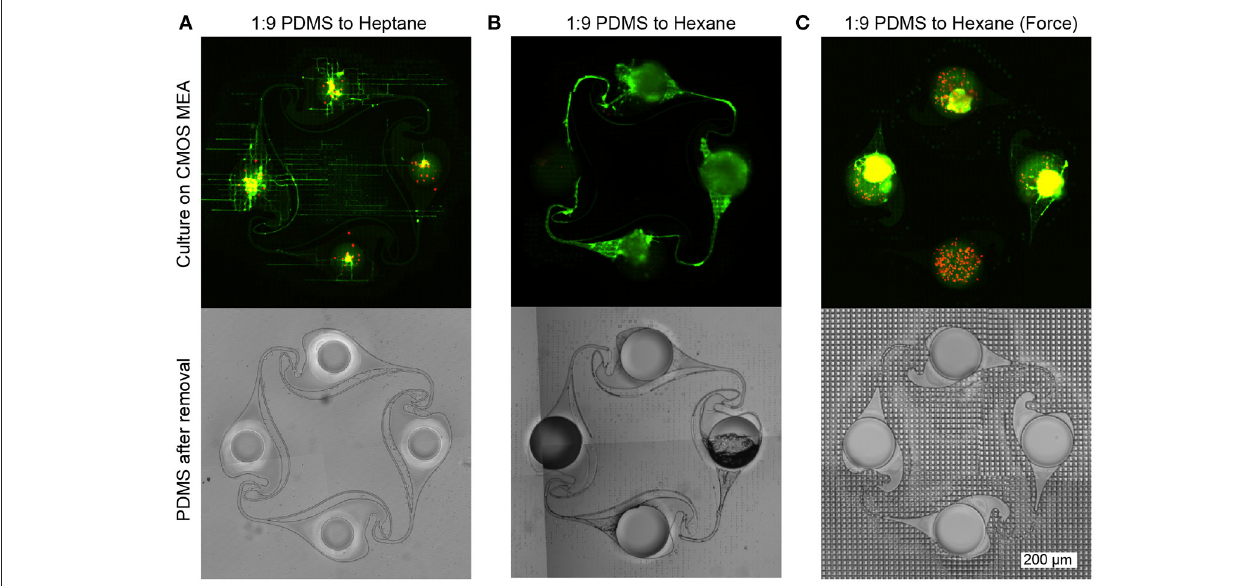
FIGURE 4 | Neuron viability and growth assessment (top row) using live-dead staining (green: alive, red: dead) and corresponding PDMS microstructure brightfield images after mask removal (bottom row). (A) The adhesion of the microstructure is low when heptane is used instead of hexane as a dilutant, since the same spincoating parameters resulted in a thinner PDMS film on the wafer. Consequently, less PDMS is transferred by the microstructure onto the CMOS array resulting in incomplete sealing of the trenches on the chip surface. Therefore, axons can escape the PDMS microstructure more easily and instead follow the topology of the MEA surface rather than the channels of the microstructure. After removing the microstructure from the MEA, a phase contrast image of the microstructure reveals that the MEA surface left almost no imprint on the PDMS microstructure, confirming that the intermediate PDMS layer did not fill the trenches of the MEA surface. (B) Using a spincoated 1:9 PDMS:Hexane film yields the best microstructure adhesion and axonal guidance. After removing the microstructure, the imprint of the surface of the CMOS MEA is visible. While some clogging is observable in the thin channels, the large channels interconnecting the nodes remain open. (C) When pressing the PDMS microstructure onto the CMOS MEA or using less diluted PDMS solutions, clogging is observed in all channels and only little axonal outgrowth is possible. The phase contrast image of the microstructure confirms the clogging, as the MEA surface imprint is also visible in the channel